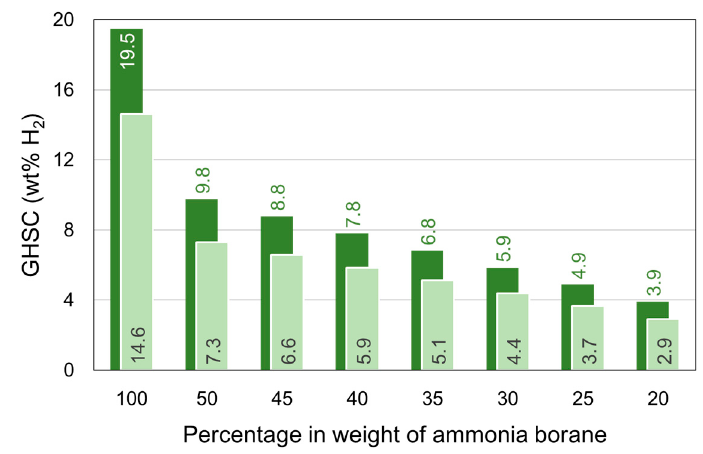
Figure 17. Gravimetric hydrogen storage capacity (GHSC) of ammonia borane (20 to 50% in weight) confined into a scaffold (80 to 50% in weight). For comparison, pure ammonia borane (100% in weight) is also shown. With respect to the bars with no border, the capacity is based on 100% on the hydrogens of ammonia borane. For the bars with the white borders, it is assumed that 75% of the hydrogen of ammonia borane can be released. The capacities (in wt% H 2 ) are all given.